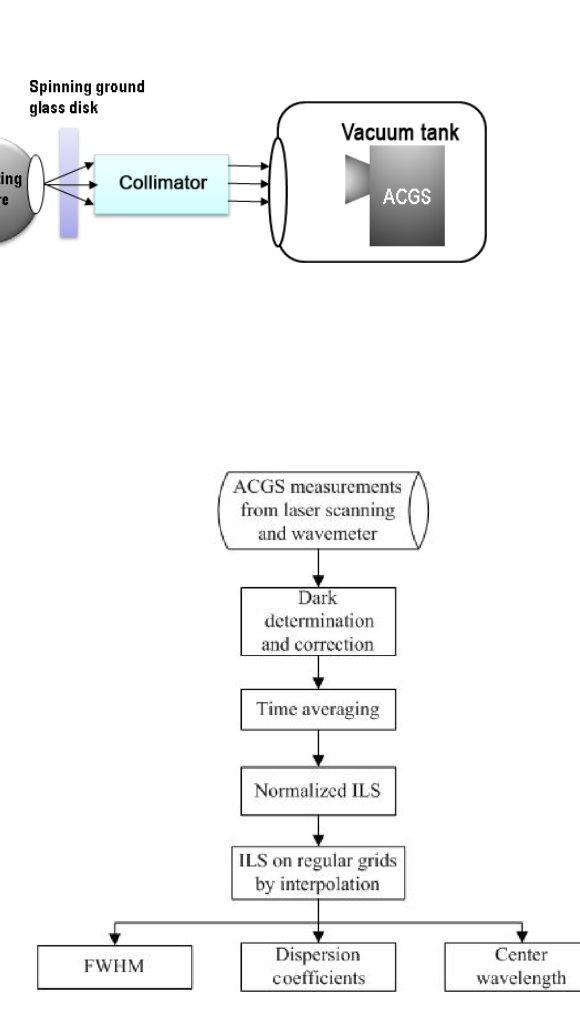
Figure 2. Flowchart of the instrument spectral calibration data pro-